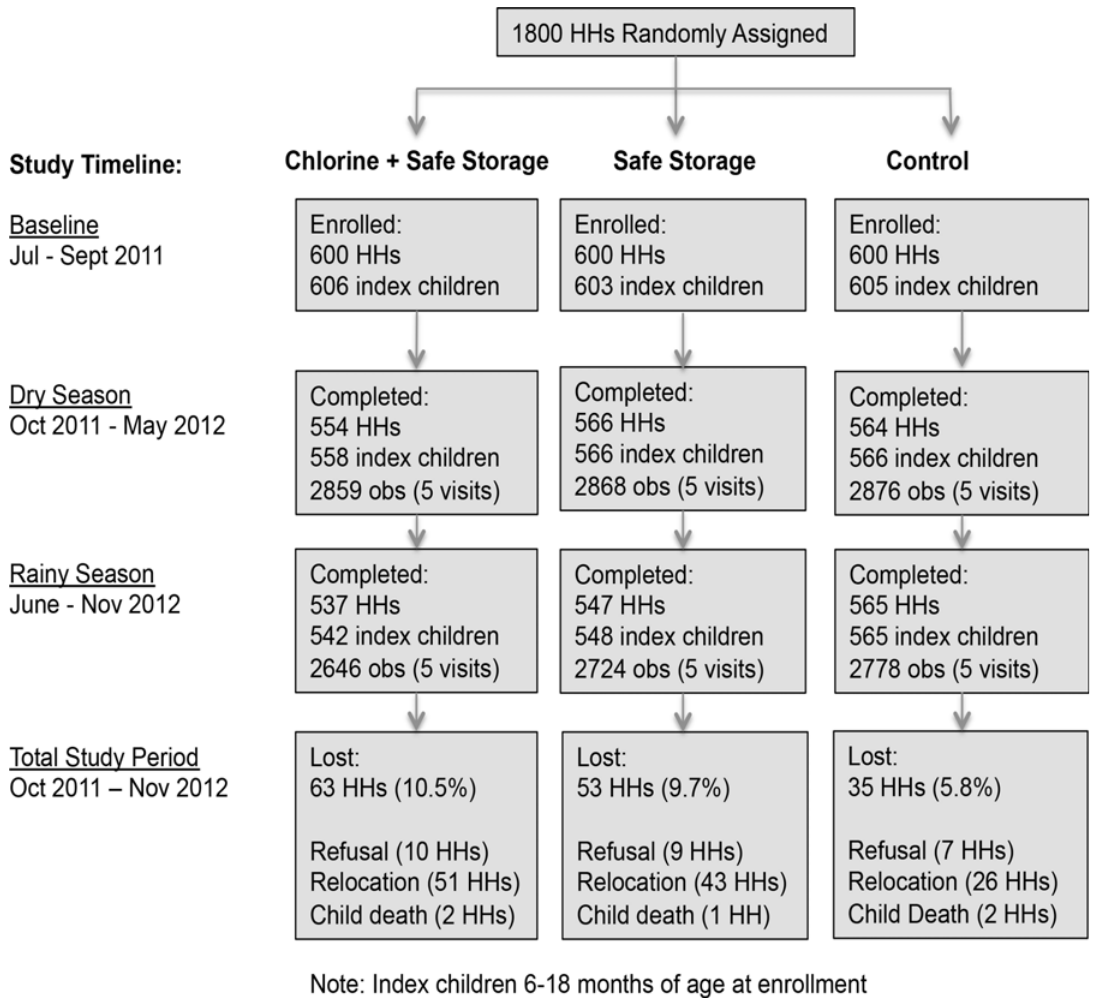
Fig 1. Flowchart of study